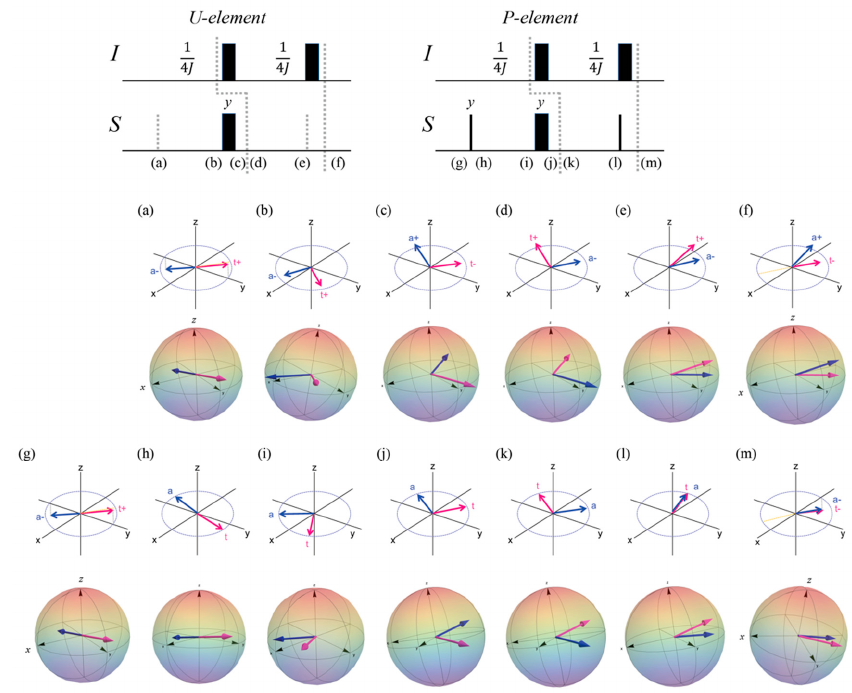
Figure 5. Behaviors of magnetization vectors in the U-element ( a–f ) and P-element ( g–m ) periods in rc CPMG rd experiments, shown by a vector model in the rotating coordinate system. The vectors of the TROSY S y I β and anti-TROSY − S y I α magnetization components are indicated by red and blue arrows, respectively. The signs “+” and “ − ” indicate that the corresponding vector is above and below the x – y transverse plane, respectively. It is assumed that the initial magnetization − 2 S y I z already contain errors that has accumulated during the previous CPMG 1 period. The two vectors representing − 2 S y I z are initially directed along orientations deviating from the ± y axis by ( θ , φ ) = (10, 10) for S y I β and by ( θ , φ ) = (10, − 10) for − S y I α in ( a , g ), where θ and φ represent the azimuth and altitude angles in a polar coordinate system, respectively. The evolution of spin S by 1 J IS coupling is included during the total delay 1/(2 1 J ), but the chemical shift evolution of spin S is removed.